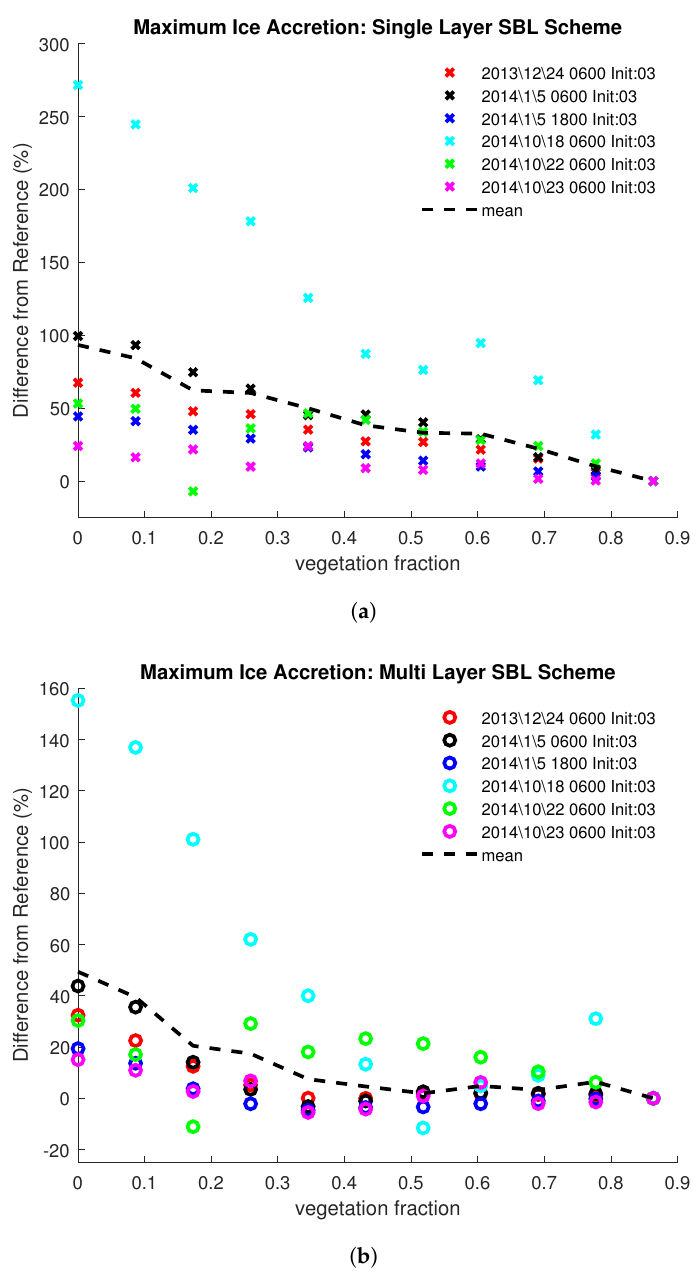
Figure 5. Percent difference of maximum ice mass accretion during the simulation from the 86.3% vegetation case as a function of vegetation fraction for all cases. ( a ) is the response with the single layer SBL scheme and ( b ) is the response with the SBL scheme turned on. The black dashed lined indicates the mean for each vegetation